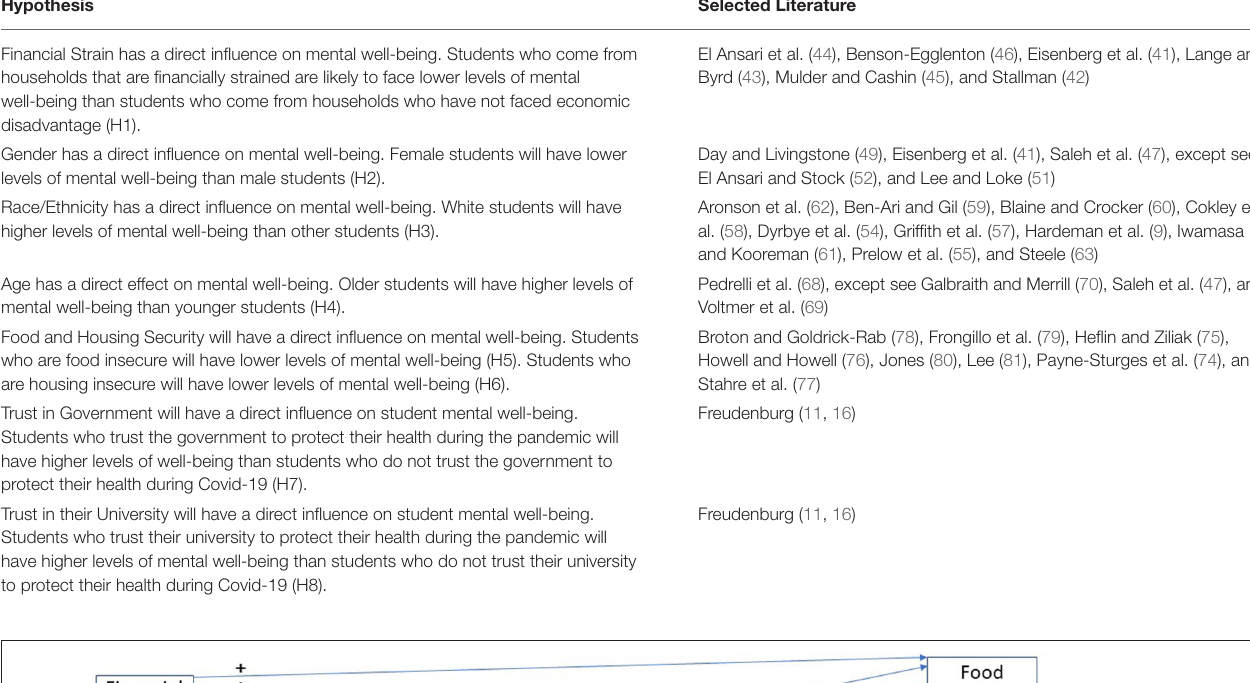
TABLE 1 | Hypotheses (paths) tested in university student mental well-being model. Hypothesis Selected Literature